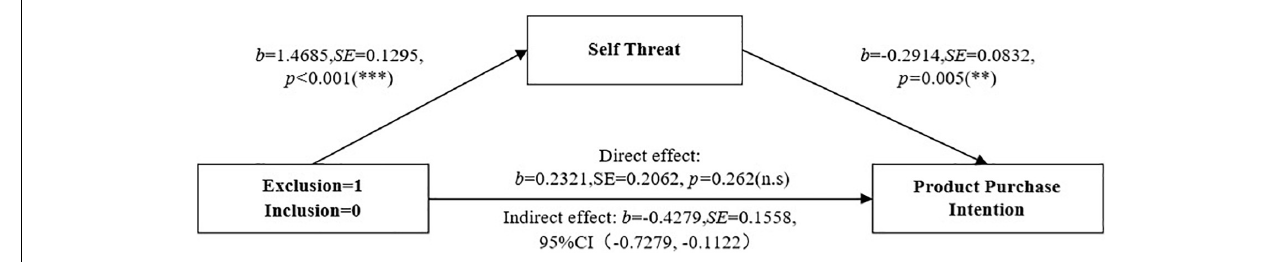
FIGURE 4 | Study 2: the mediation effect of self-threat. ∗ p < 0.05, ∗∗ p < 0.01, ∗∗∗ p < 0.001. *Significance at the 0.05 level.